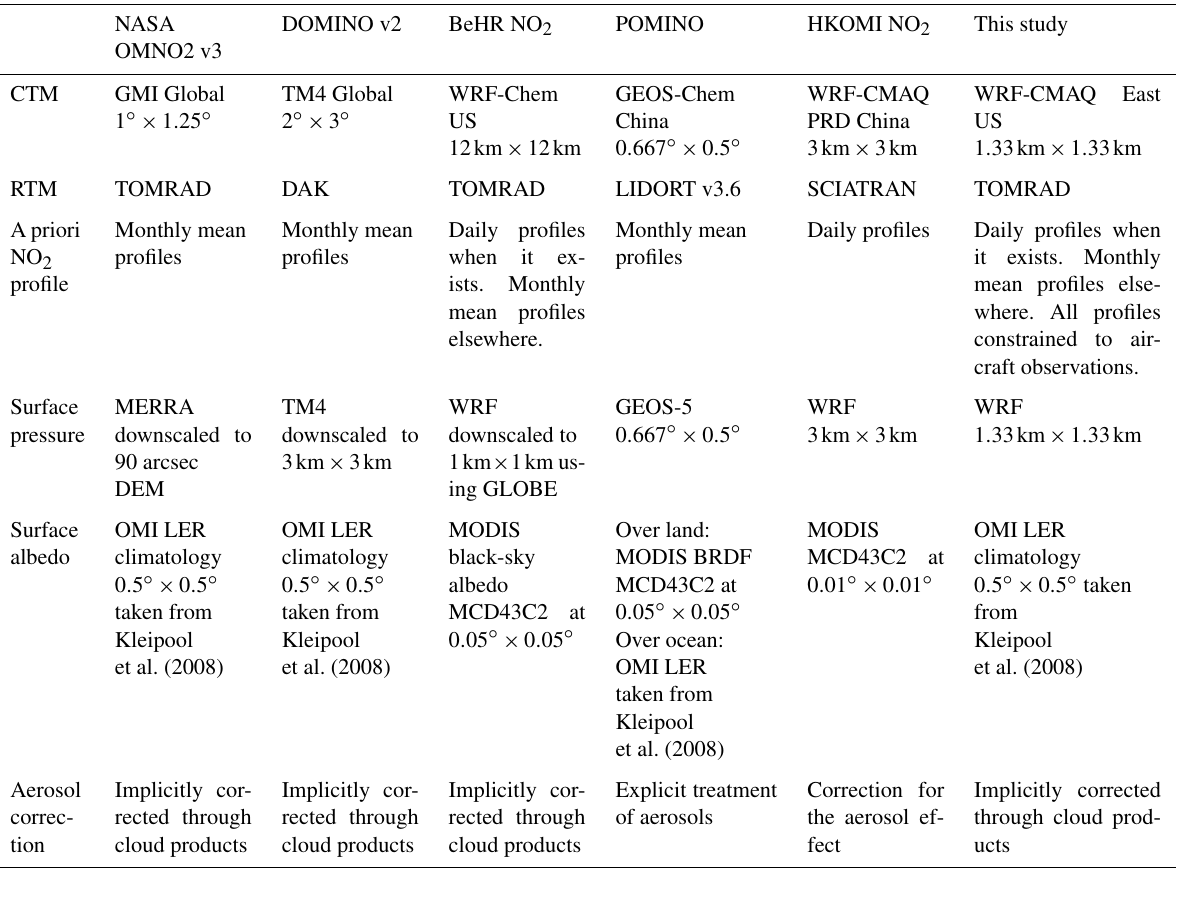
Table 1. Summary of the current OMI NO 2 retrievals in the literature.